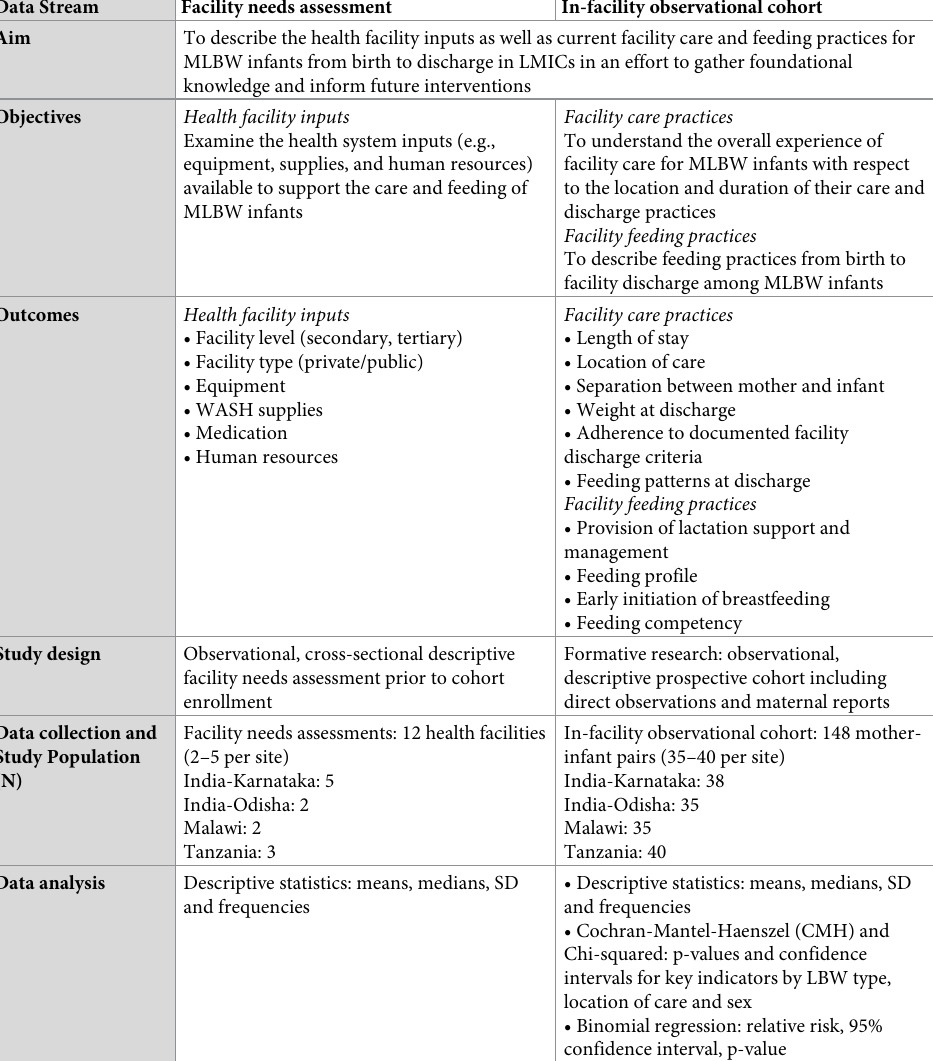
Table 1. Overview of study objectives and data